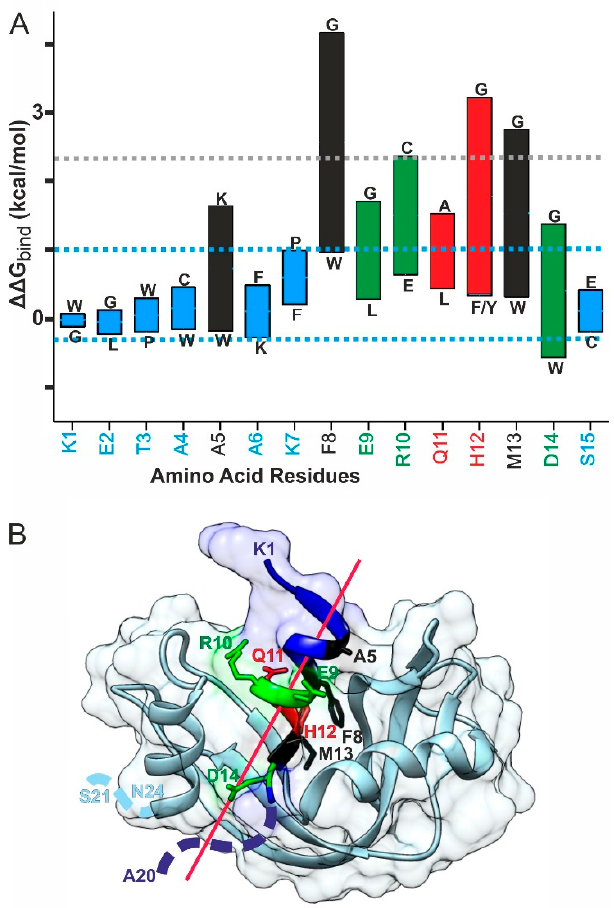
Figure 6. ( A ): Relative binding energy changes between S-peptide and S-protein upon site-specific exchange of amino acid residues of the S-peptide. Wild-type amino acid residues of the S-peptide are shown at the bottom. Black: non-polar residues; red: polar residues; green: ionic residues; blue: residues with no substantial influence on complex stability. Vertical bars show the ∆∆ G bind energy ranges after point mutations. Mutated amino acid residues with the highest and the lowest ∆∆ G bind values are shown above and below their respective bars. The dashed blue lines indicate borders within changes of ∆∆ G bind values do not cause significant stability changes. The dashed gray line indicates the border at twice the height of the range which spans from the bottom to the upper dashed blue line. ( B ): Three-dimensional structure representation of RNAse S. Atom position data are from 1J80.pdb. The atoms’ surfaces of the amino acid residues of the S-peptide (Connolly surfaces using van der Waals radii) are colored in blue whereas the S-protein surface is indicated in light blue. The backbones of the amino acid sequences of the S-peptide (blue) and the S-protein (light blue) are shown as ribbons (cartoon view). The side-chain atoms of the amino acid residues from the S-peptide which are involved in contacts with the S-protein are depicted as stick models. The red line marks the central axis of the S-peptide helix. Dashed blue lines indicate arbitrary backbone locations of amino acid residues for which no positions were stored in the PDB file. Amino acid residue color code as in ( A